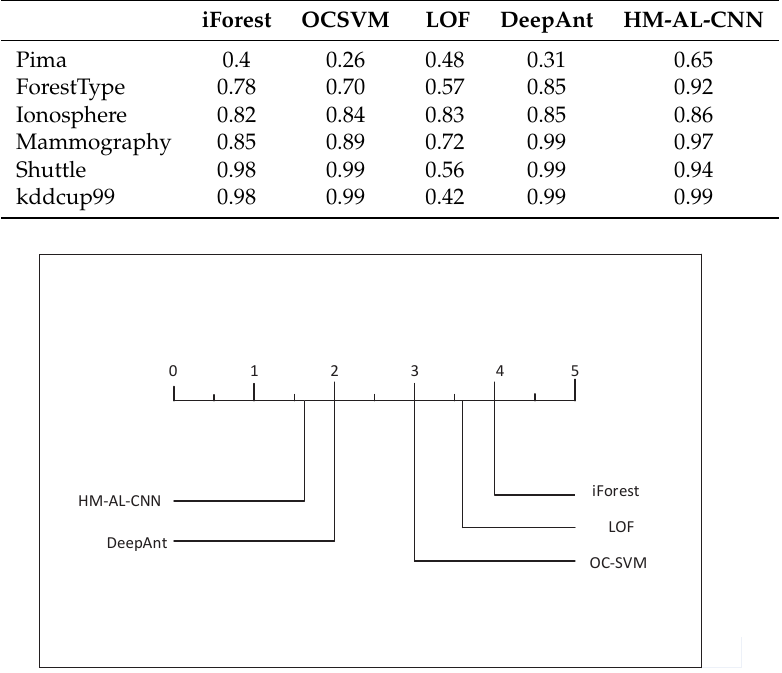
Figure 7. Critical difference of the arithmetic means of the ranks on six